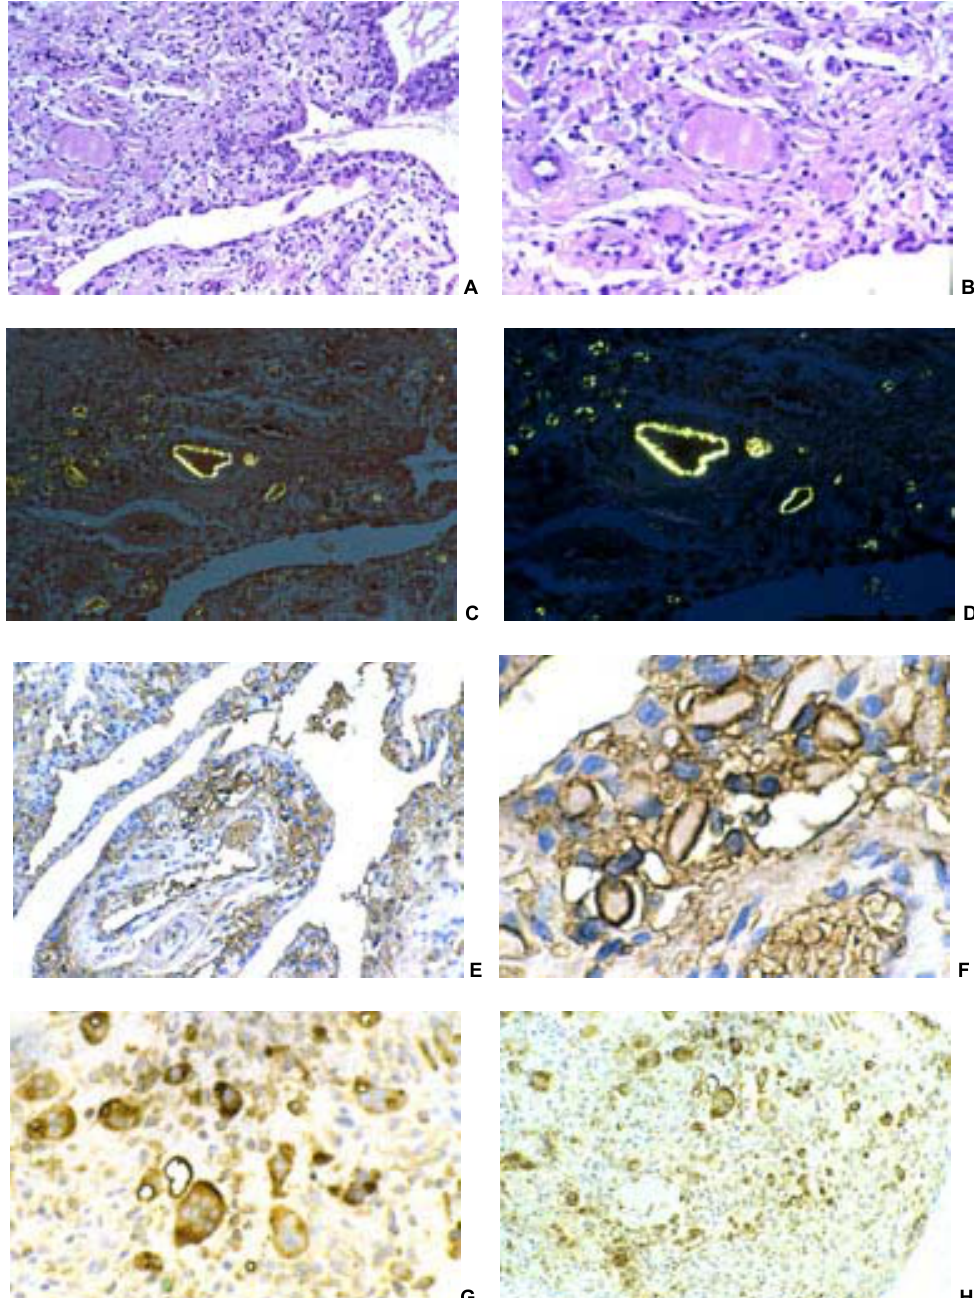
FIGURE 4A-H. Synovial membrane. Systemic β 2-microglobulin (A β 2M) amyloidosis. (A,B) A β 2M deposits, extracellular and incorporated by macrophages. Hematoxylin and Eosin, (A) × 125, (B) × 200. (C,D) Performate pretreatment for 3 sec, Congo red staining, viewed under polarized light. A β 2M deposits are resistant to performate pretreatment ( for 1-15 sec), (C) × 125, (D) × 200. (E,F) Systemic A β 2M deposits are positive for a-hu β 2-microglobulin 1:400 (polyclonal antibody A0072; DAKO, Glostrup, Denmark), Streptavidin-biotin complex/horseradish peroxidase reaction, (E) × 50, (F) × 200. (G,H) Synovial membrane, macrophages with incorporated β 2-microglobulin. Positive staining for a-hu β 2- mikroglobulin 1:400 (polyclonal antibody A0072; DAKO, Glostrup, Denmark), Streptavidin-biotin complex/horseradish peroxidase reaction, (G) × 125, (H) ×